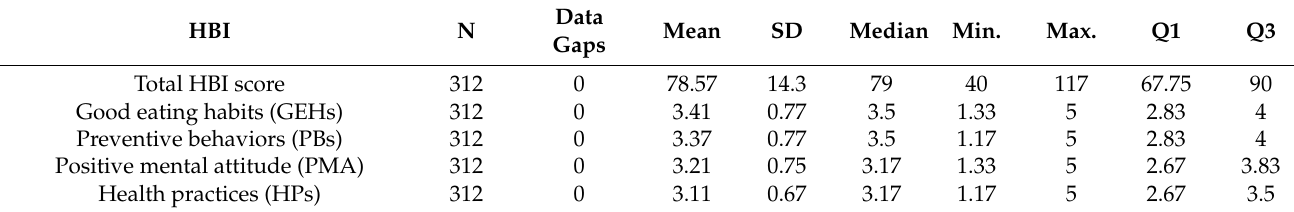
Table 3. Individual HBI